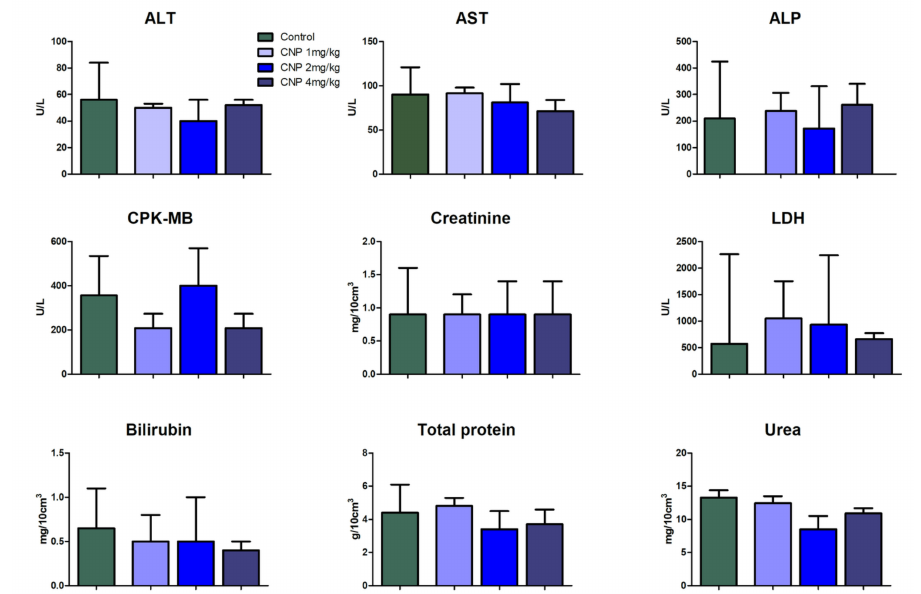
Figure 10. Rat blood biochemical parameters at 14 days after intravenous CNP administration. Median ± range. CNPs were mostly accumulated in the liver and in a lesser extent in the lungs. Kidneys, spleen, and heart accumulated about one percent of all nanoparticles. CNP could a ff ect these organs and impair their functions. Biochemical parameters related to the liver, kidney, and heart did not reveal any signs of injury or malfunction.